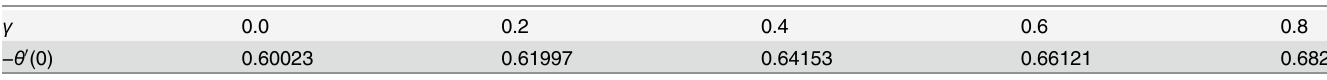
Table 5. Values of heat transfer rate at the surface − θ 0 (0) in second grade fluid when k (cid:3) 1 ¼ (cid:2) 0 : 2 and Pr = 1.0. γ